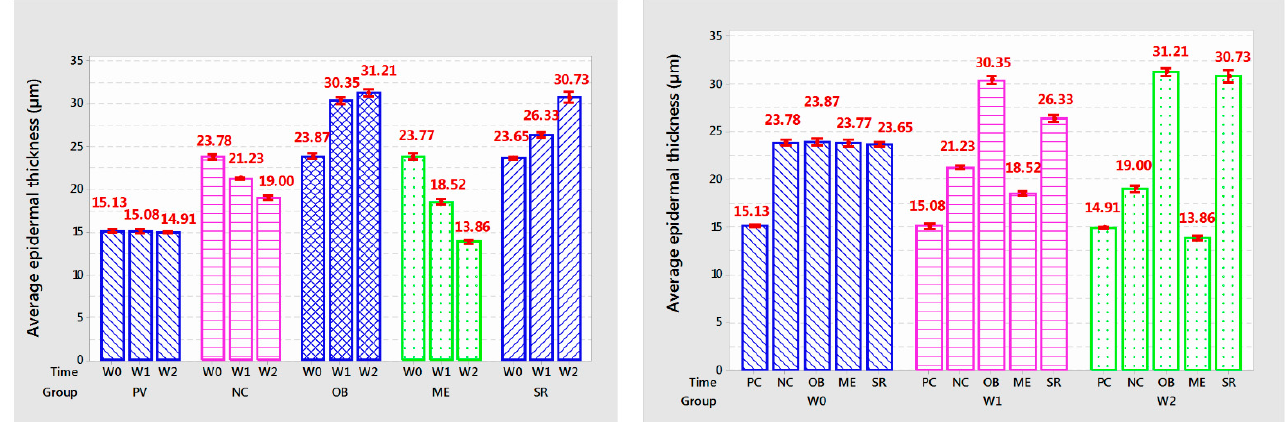
Figure 7. The graph shows the average epidermal thickness of the mouse skin after each week of